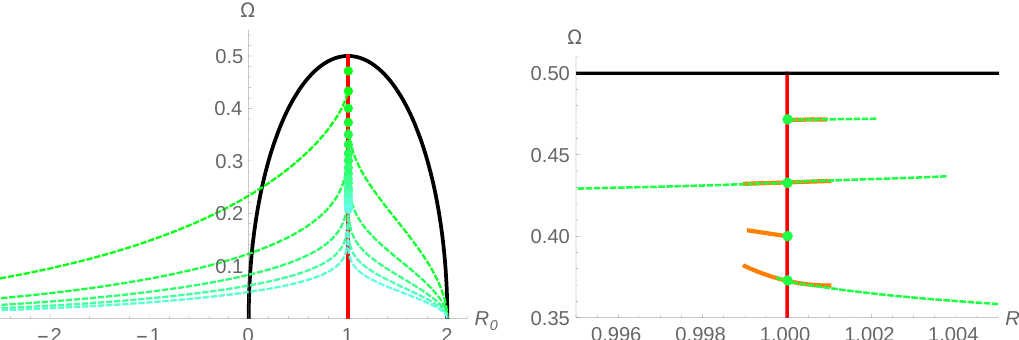
Figure 11 . Branches of black bar deformations on the ( R 0 ; (cid:10)) plane. The right plot is a close-up showing good agreement with the analytic expansions (orange) and also zooms in on the short branches. Di(cid:11)erent tones of green are being used for di(cid:11)erent branches for the sake of clarity.